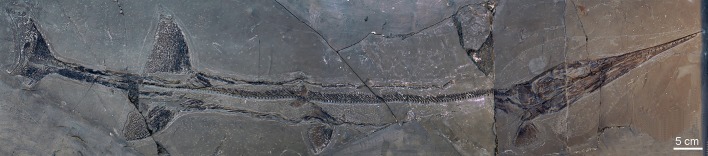
Saurichthys deperditus (Costa, 1862), a large Late Triassic saurichthyid from marine deposits of Austria.